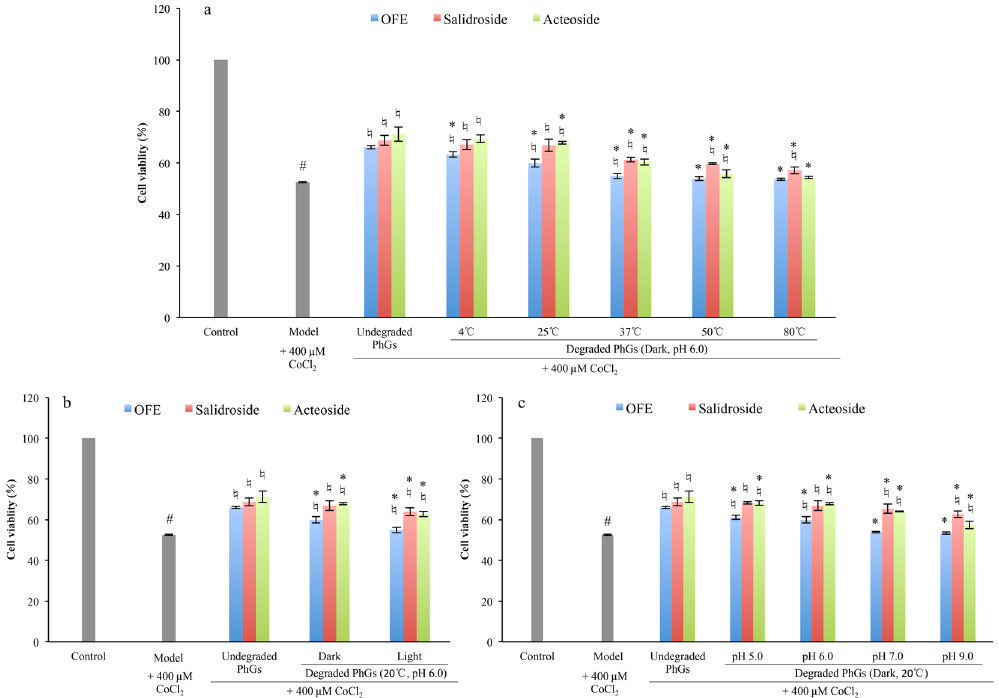
Figure 6. Protective effects of degraded PhGs on CoCl 2 -induced hypoxia damage in PC12 cell. a, cell viabilities of PC12 cells treated with PhGs stored at different temperature at pH 6.0 in the dark; b, cell viabilities of PC12 cells treated with PhGs stored at different light exposure at pH 6.0 at 20 °C; c, cell viabilities of PC12 cells treated with PhGs stored at different pH at 20 °C in the dark. PhGs, phenylethanoid glycosides; OFE, O. fragrans var. thunbergii flower extracts. Cell viabilities were measured by CCK-8 assay. # p < 0.05 compared with control group; ♮ p < 0.05 compared with model group ( + 400 µ M CoCl 2 ); * p < 0.05 compared with undegraded PhGs in the same